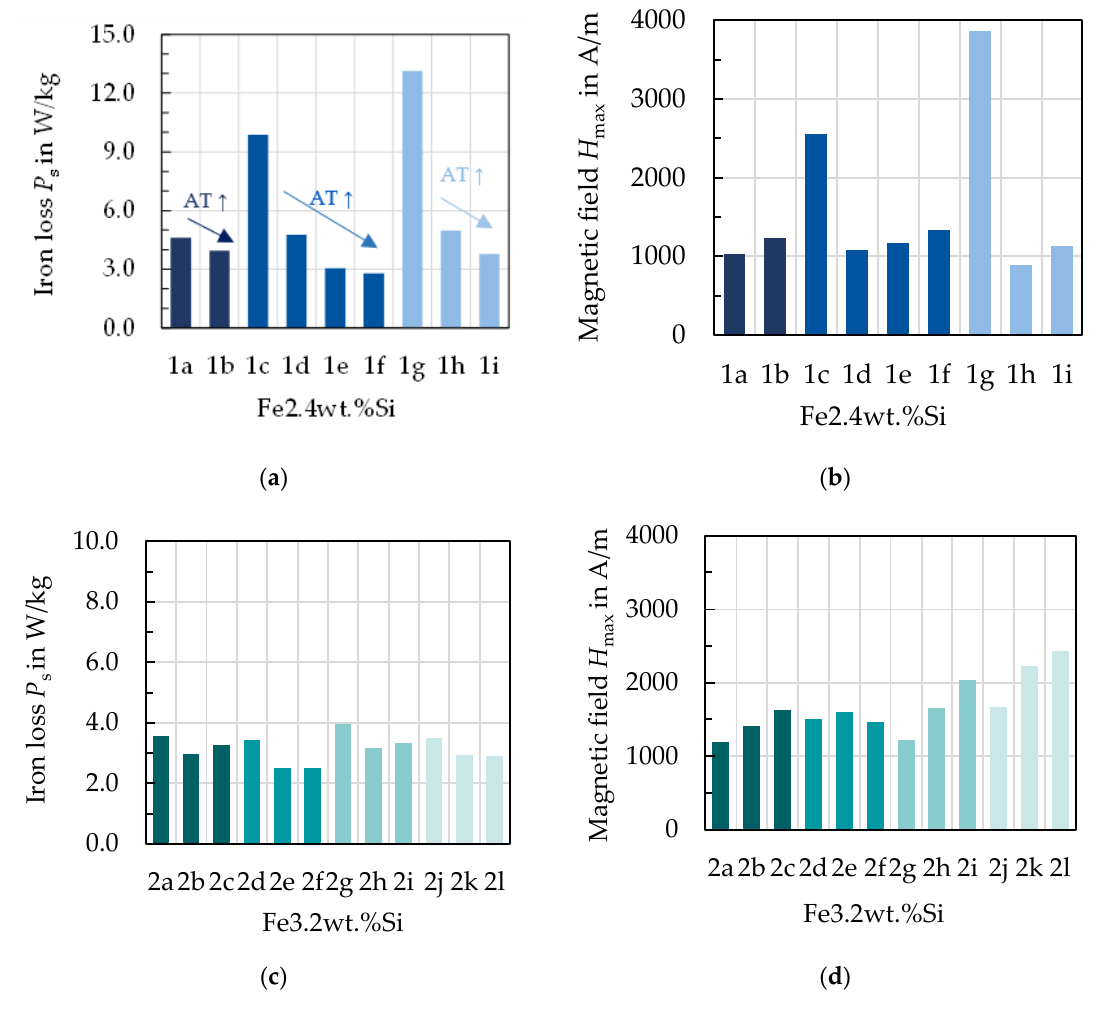
Figure 4. Magnetic properties of the studied material grades at 1.5 T and 50 Hz, with the same color indicating that only annealing temperature (AT) as highlighted in ( a ) has changed for these states: ( a ) loss for Fe–2.4 wt % Si; ( b ) magnetization for Fe–2.4 wt % Si; ( c ) loss for the Fe–3.2 wt % Si; ( d ) magnetization for Fe–3.2 wt % Si.